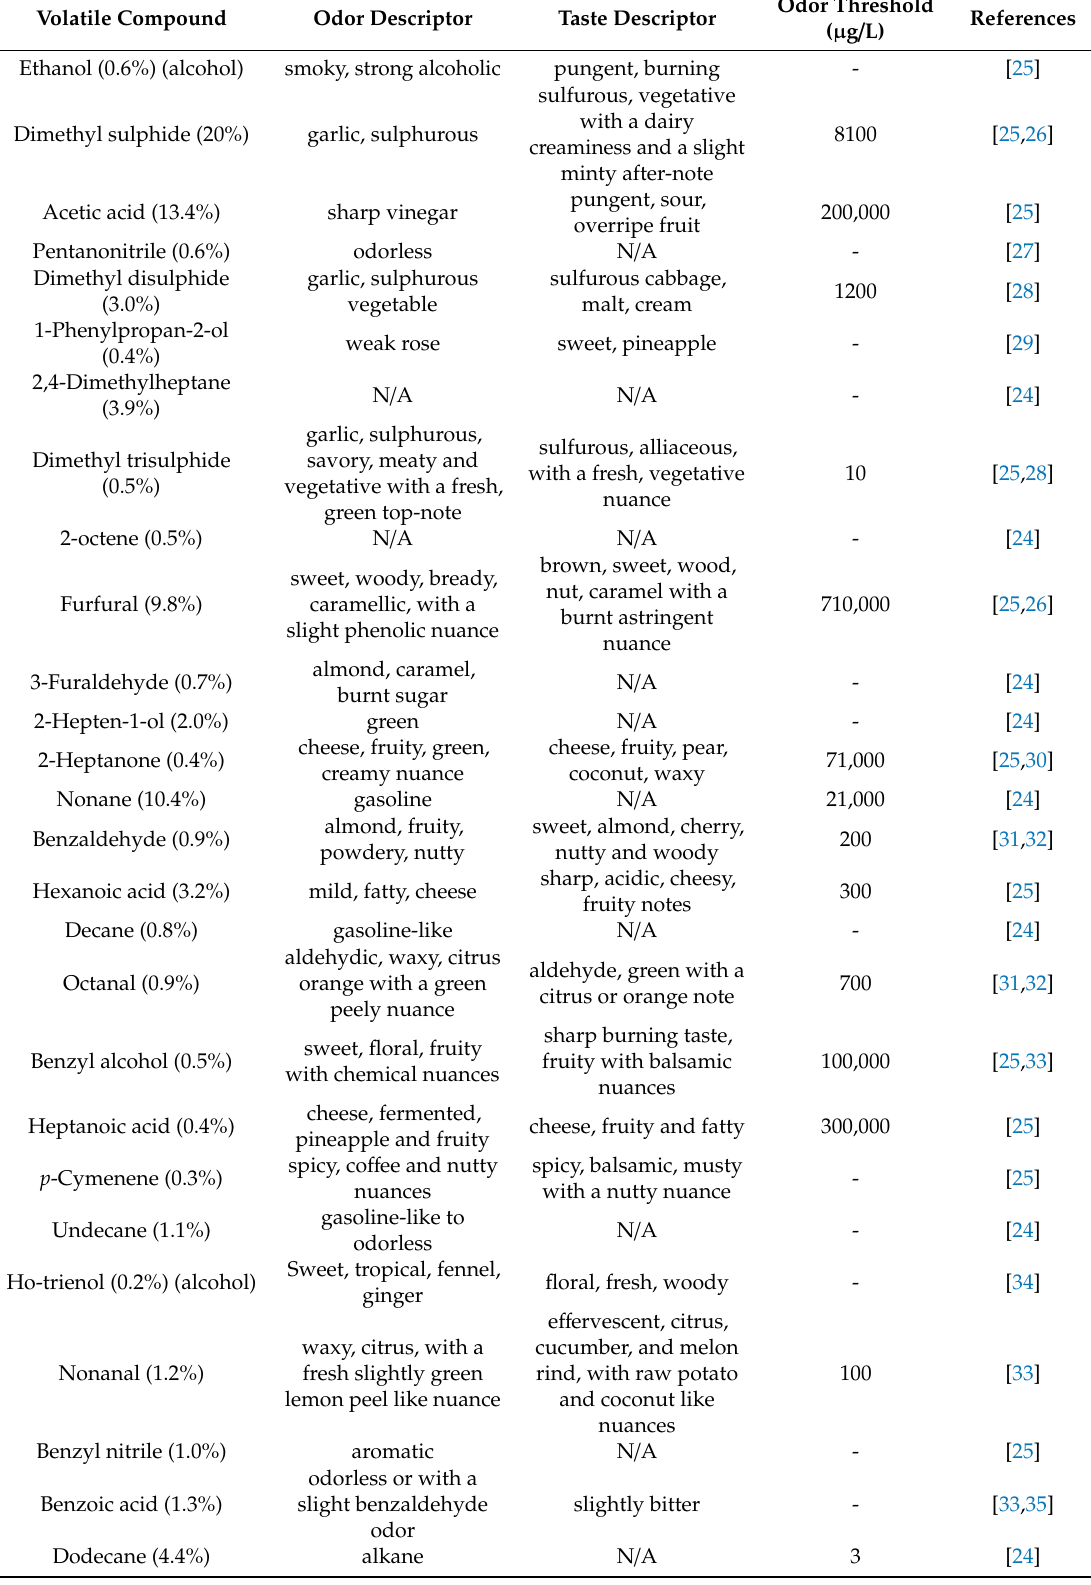
Table 1. Odor and flavor descriptors of some volatile compounds found in BB (adapted from